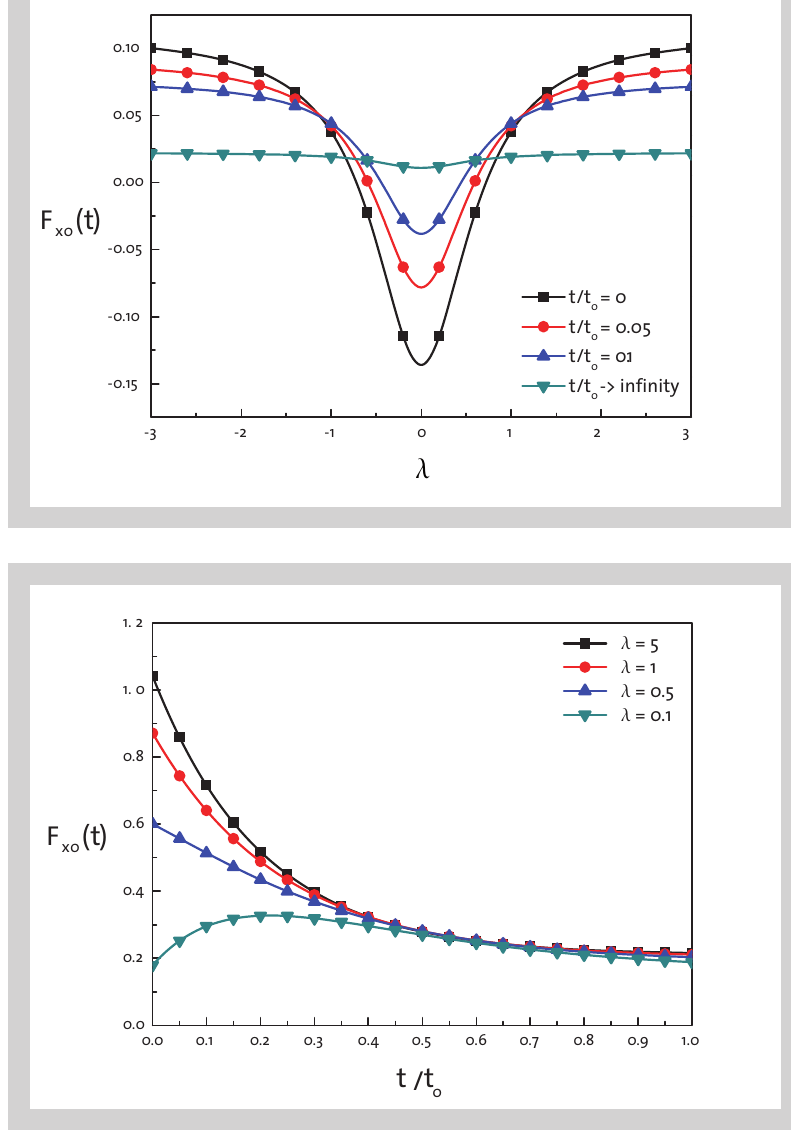
Figure 5: Normalized force F (t) x0 versus l with different t/t o for a = 5, x = 2, b = 0.8, and q = p /6. Figure 6: Normalized force F (t) x0 versus t/t with different l o for a = 5, x = 1, b = 0.85, and q = p